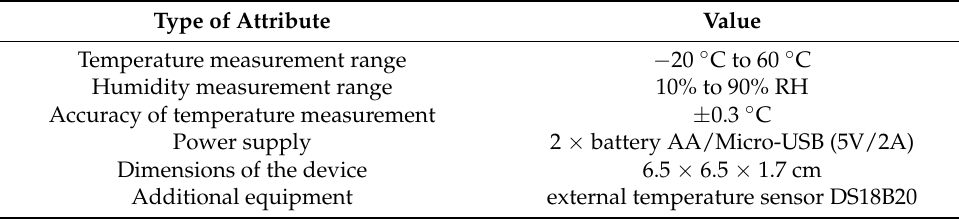
Table 2. Technical characteristics of the electronic thermometer type UbiBot WS1.